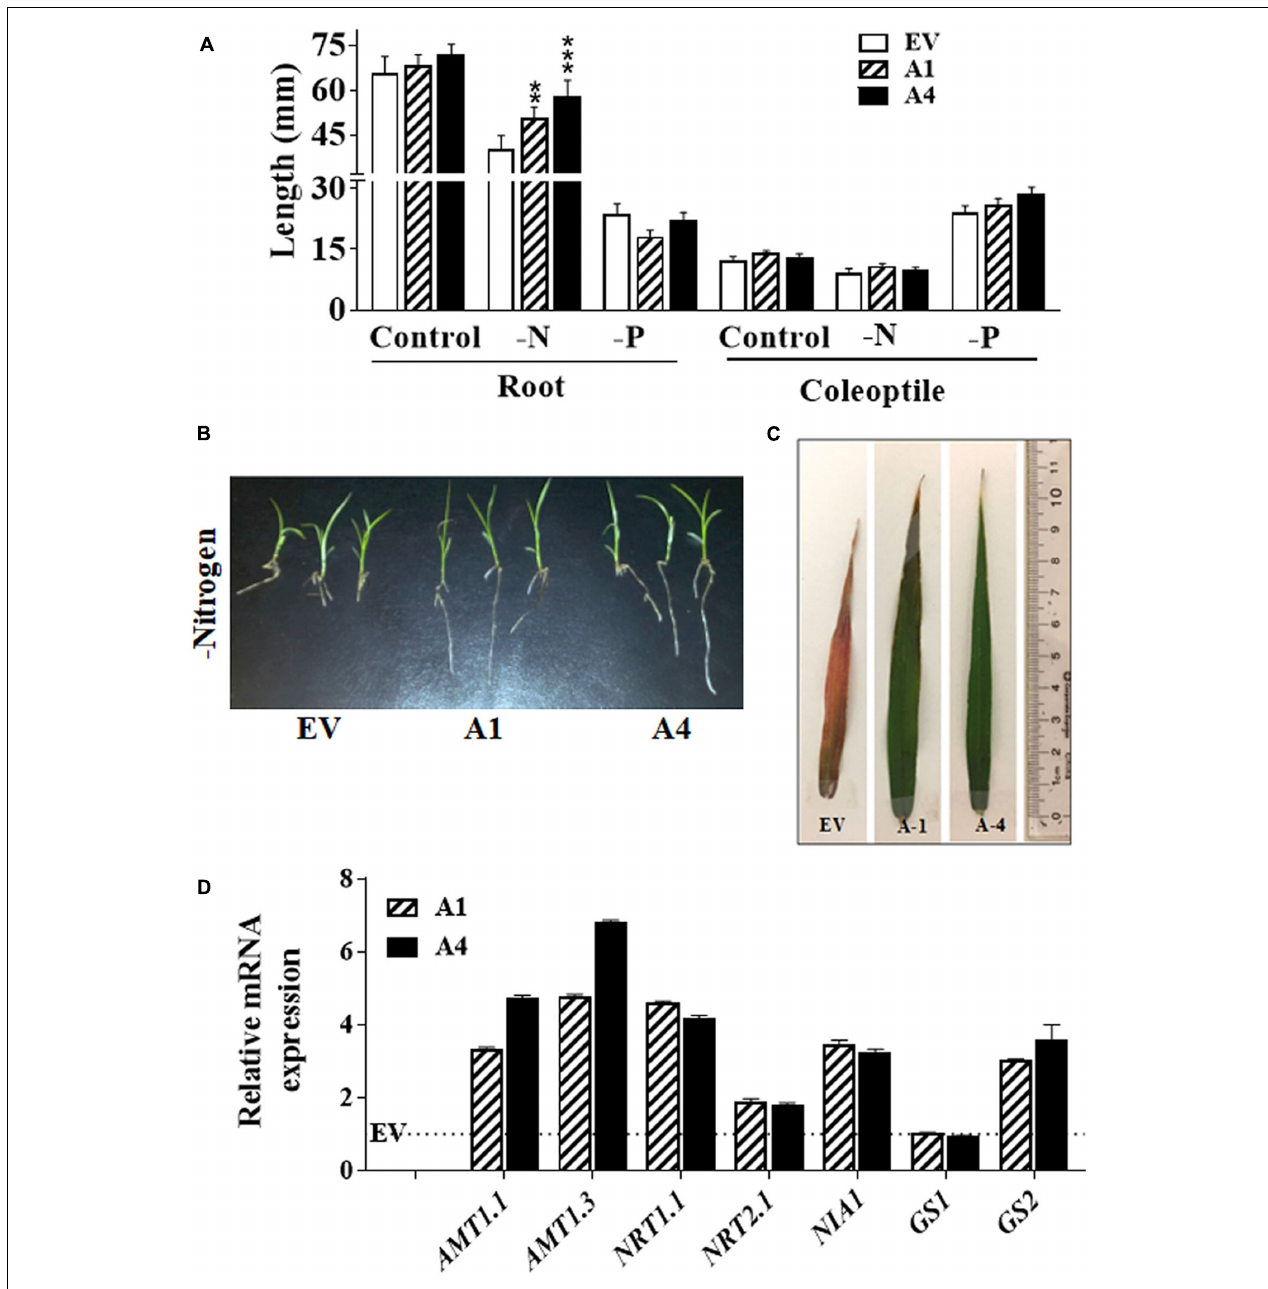
FIGURE 3 | Effect of nitrogen limiting conditions on growth of AGG3OE Setaria plants. (A) Root and coleoptile lengths of 1 week old seedling grown on 0.5 X MS media lacking nitrogen or phosphate sources. The data represent the mean values ( ± SE) from sixty seedlings. Asterisks represent P -values ≤ 0.01 ( ∗∗ ) or ≤ 0.001 ( ∗∗∗ ) as calculated using Students t- test. (B) Representative picture of 2 weeks old seedlings of EV control and AGG3OE lines grown on nitrogen free media. (C) Representative picture of the flag leaf of 5 weeks old EV, A1 and A4 plants under nitrogen-limiting condition. (D) Expression levels of nitrate transporter and metabolism genes in 2-week old S. viridis A1 and A4 plants. Dotted line represents the expression values of the genes (assigned as 1) in EV control plants. The data represent mean values ( ± SE) of three biological